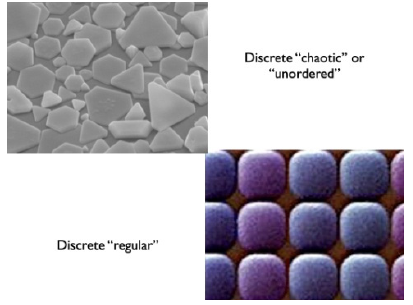
Figure 1. Analog and digital discontinuity.